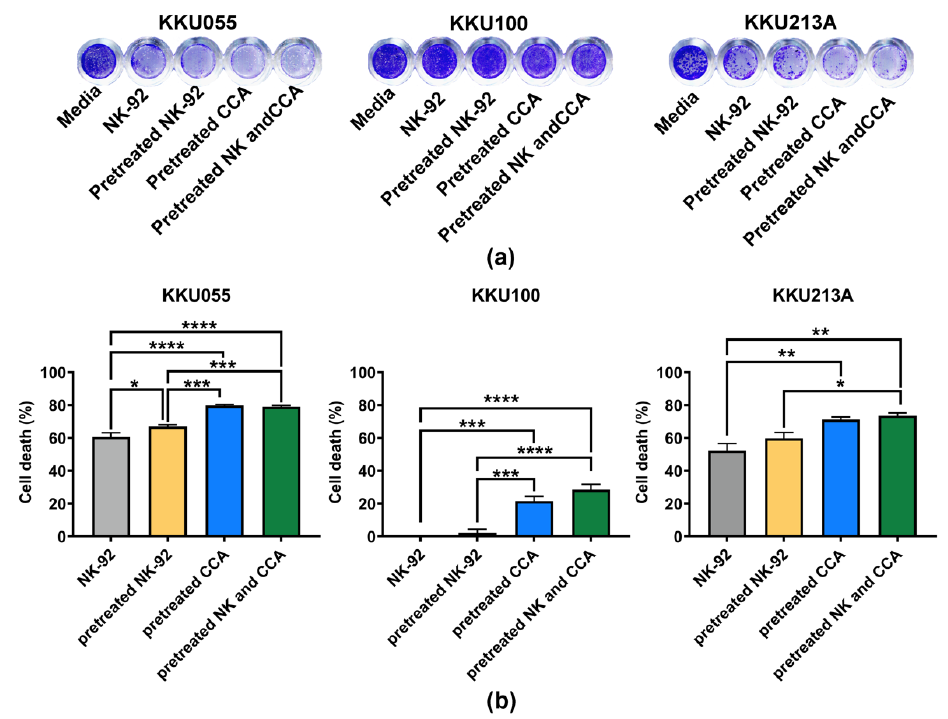
Figure 5. Killing of CCA cells by NK-92 cells examined by killing assay. ( a ) The living cells were determined after 24 h of coculturing CCA cells and NK-92 cells by crystal violet staining by using 4 experimental conditions including (1) NK-92 alone, (2) pretreated NK-92, (3) pretreated CCA, and (4) combination of pretreated NK and pretreated CCA condition. ( b ) The percentages of cell death (% cell death), represented in bar graph, were tested for statistical differences between each condition and the control group (NK-92 alone) (* indicates p < 0.05, ** indicates p < 0.01, *** indicates p < 0.001, and **** indicates p < 0.0001).